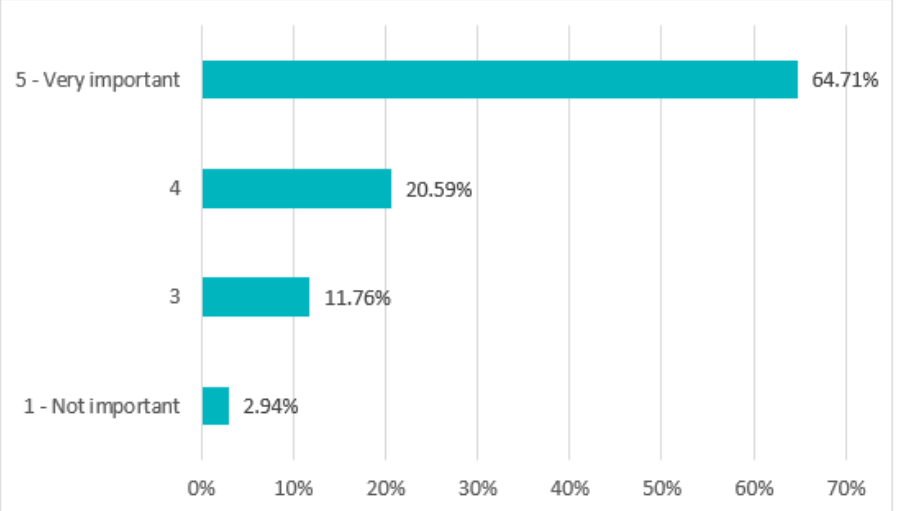
Figure 18. Importance of nearby available charging stations.